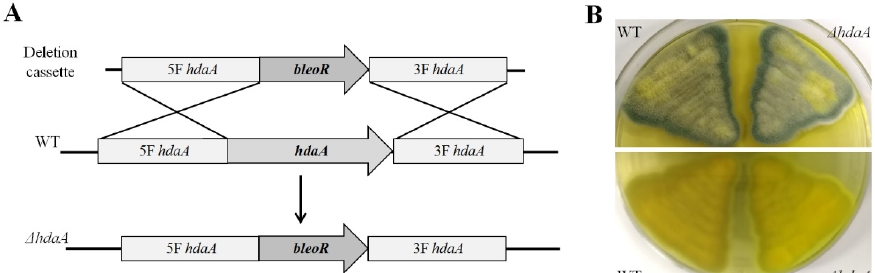
Figure 2. Generation and phenotype of the Δ hdaA strain. ( A ) Schematic illustration for hdaA disruption. The bleoR gene is amplified from the plasmid pZeo, and the bleomycin is used for the selection of transformants bearing the bleoR gene. Transformation was performed by homologous recombination using the protoplast transformation method. ( B ) The phenotype of the ∆ hdaA and WT strains grown on PDA plates (25 ◦ C for 5